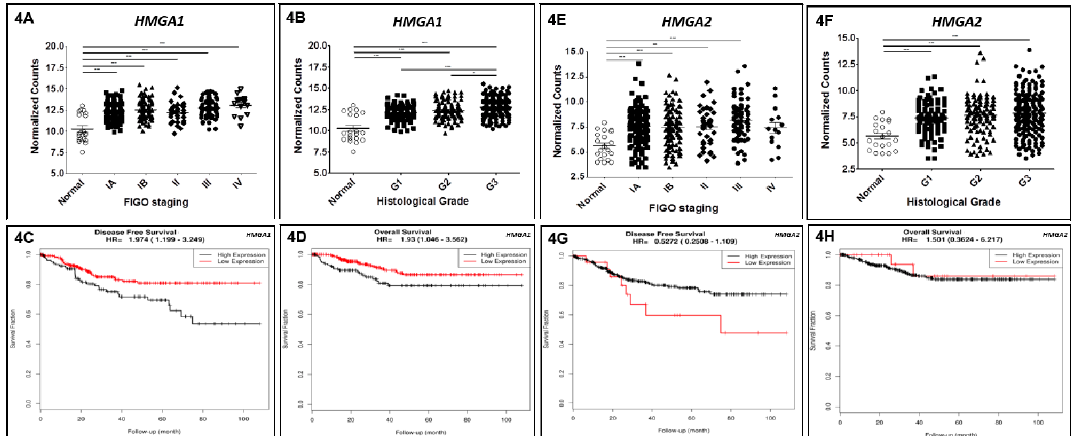
Figure 4. HMGA1 and HMGA2 expression in endometrioid endometrial adenocarcinomas